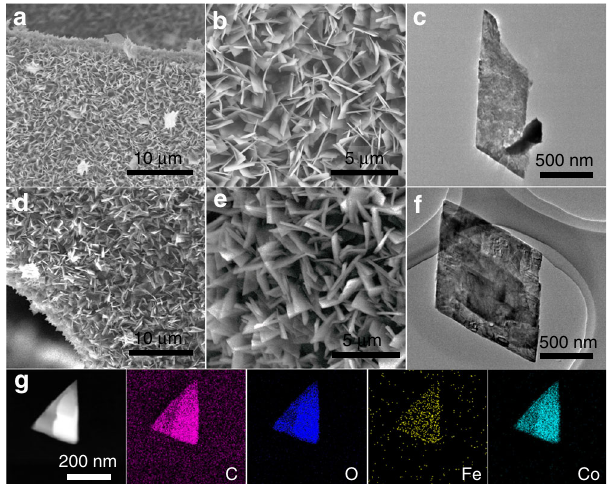
Fig. 3 Physical characterization of CoBDC – Fc – NF. a and b SEM images of CoBDC – NF. c TEM image of CoBDC – NF. d and e SEM images of CoBDC – Fc – NF. f TEM of CoBDC – Fc – NF. g HAADF-STEM image